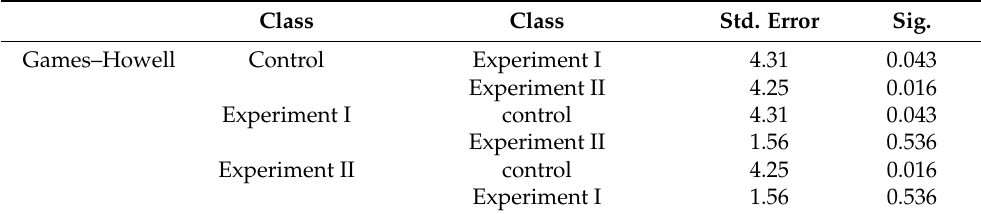
Table 3. The difference between the control class, experiment I, and experiment II using Games– Howell–based post hoc for multiple comparisons.